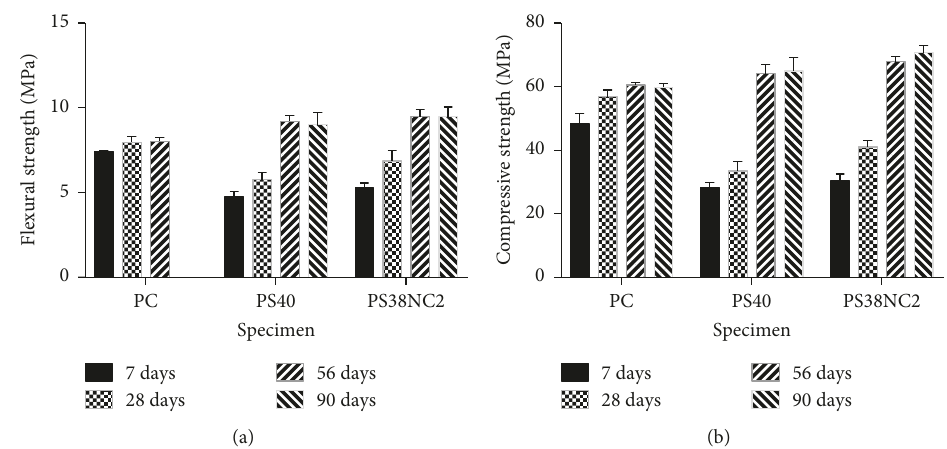
Figure 3: Strength development of mortar containing PS and